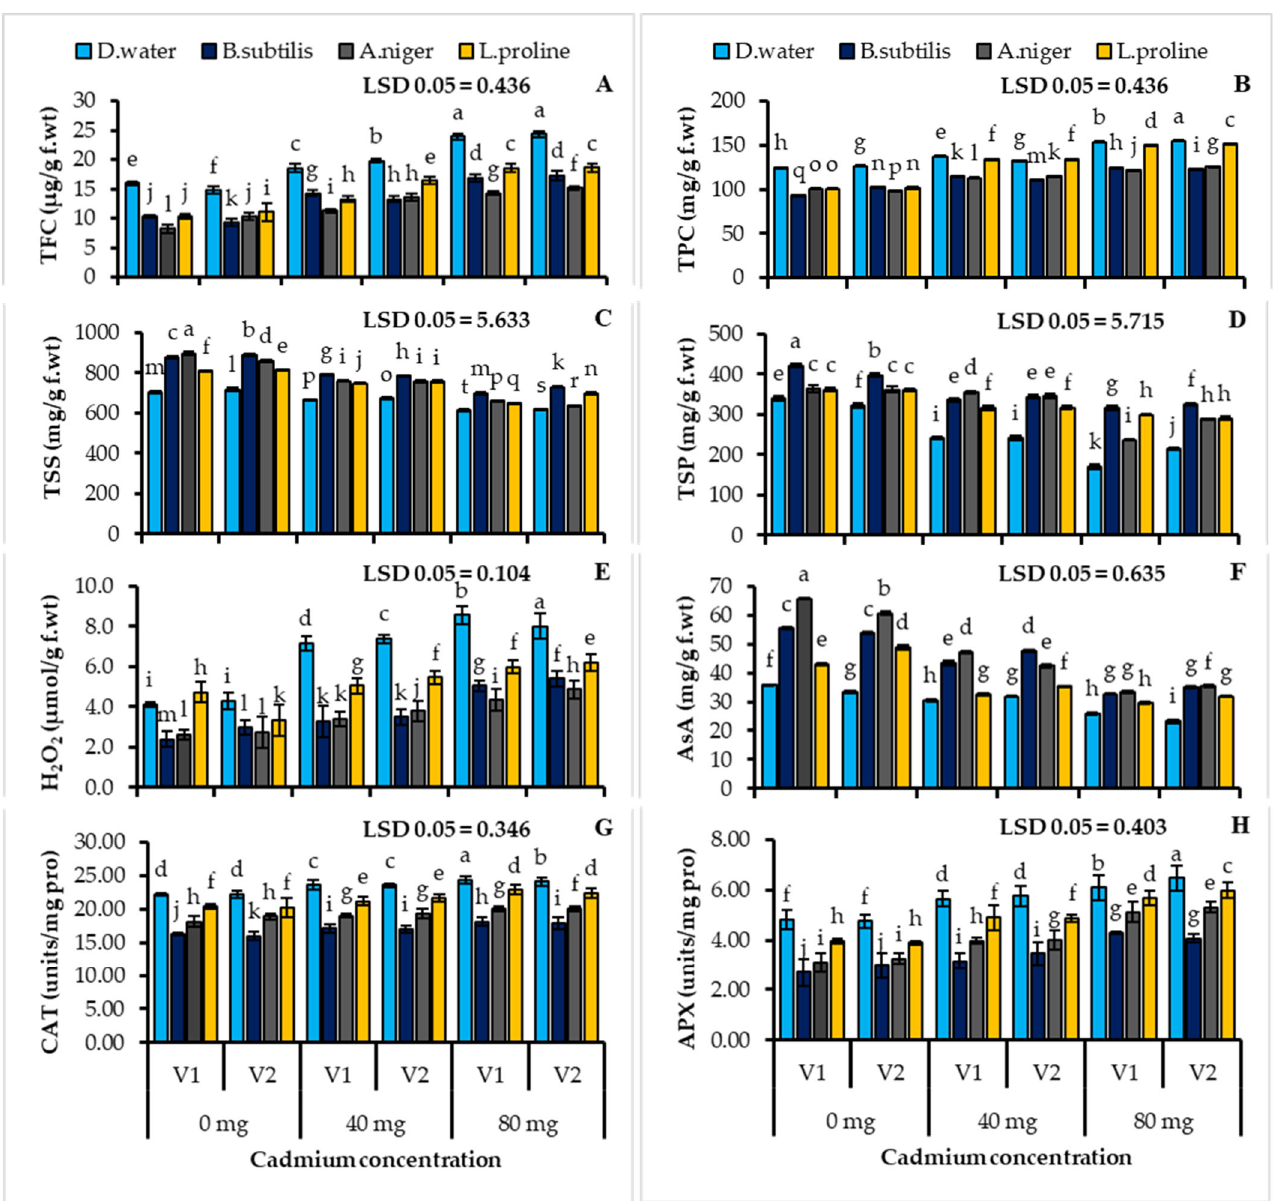
Figure 3. Total flavonoid contents ( A ) total phenolic contents ( B ) total soluble sugars ( C ) total soluble proteins ( D ) hydrogen peroxide ( E ) ascorbic acid ( F ) contents, catalase ( G ) ascorbate peroxidase ( H ) activity of two cultivars of wheat ( Triticum aestivum L.) treated with Bacillus subtilis , Aspergillus niger and L ‐ proline subjected to cadmium stress conditions (Mean ± S.E.). Here V1 = AKBAR and V2 = DILKASH. The lower ‐ case letters represent the significant difference in data.